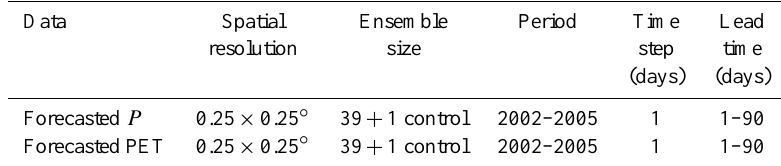
Table 2. Overview of ensemble seasonal meteorological forecast